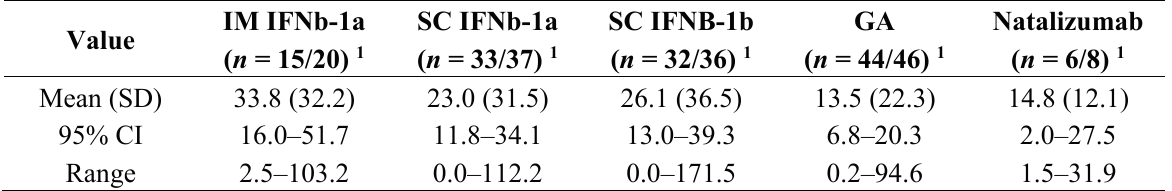
Table 1. Time interval (months) between discontinuation of previous MS-specific treatment and Visit